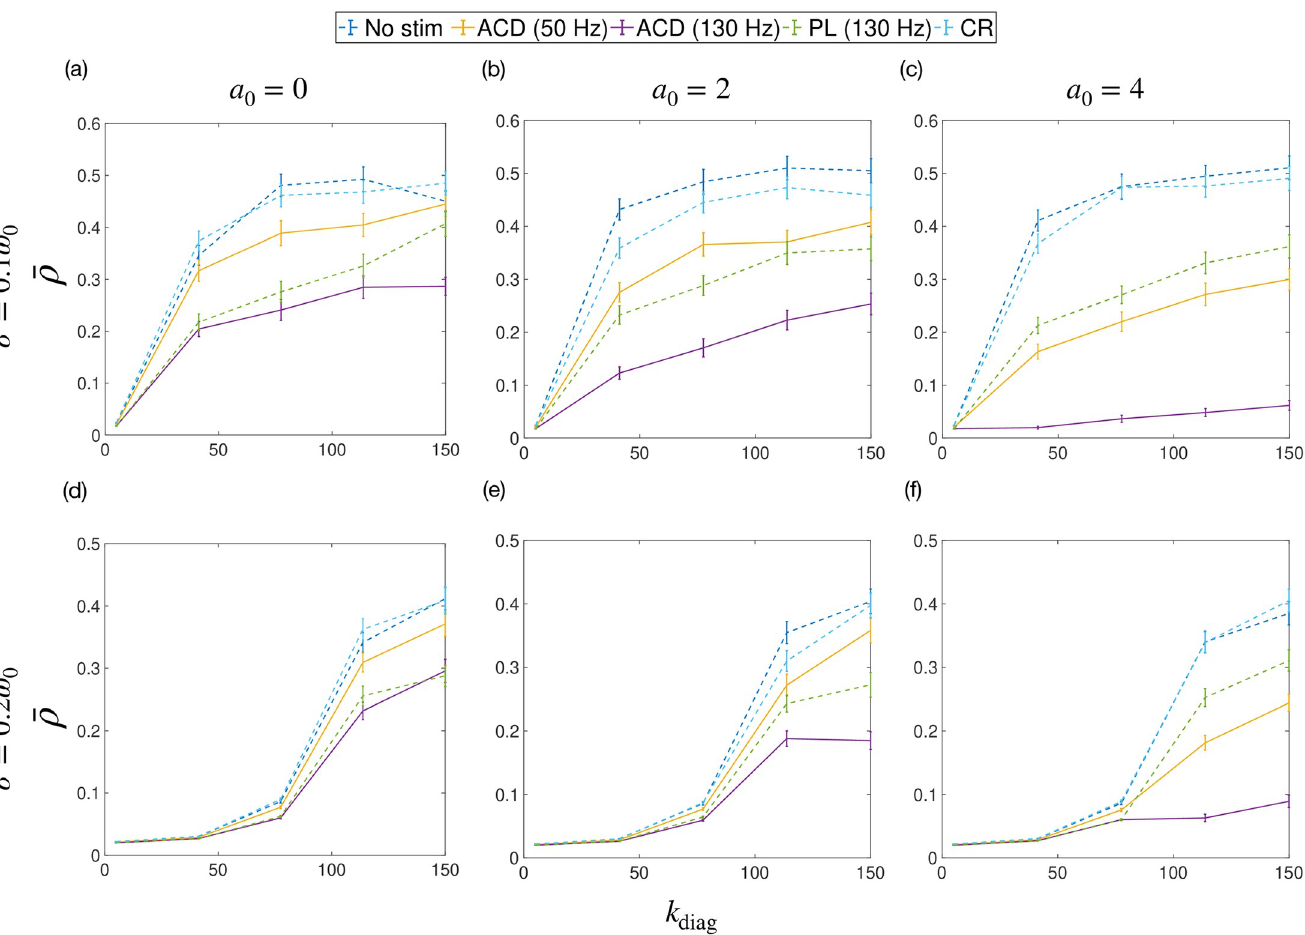
Fig 9. The average amplitude of simulated data � r as a function of the coupling constant k diag . The strategies tested were: no stimulation (no stim), adaptive coordinated desynchronisation (ACD), phase-locked (PL) and coordinated reset (CR). The average amplitude is a measurement of efficacy, where lower amplitudes indicate higher efficacy. The maximum stimulation frequencies used for ACD and PL are also given in the legend. Solid lines are for the ACD method. Each sub plot shows a set of simulations performed with a particular zeroth harmonic of the uPRC a 0 and value of noise ~ s .